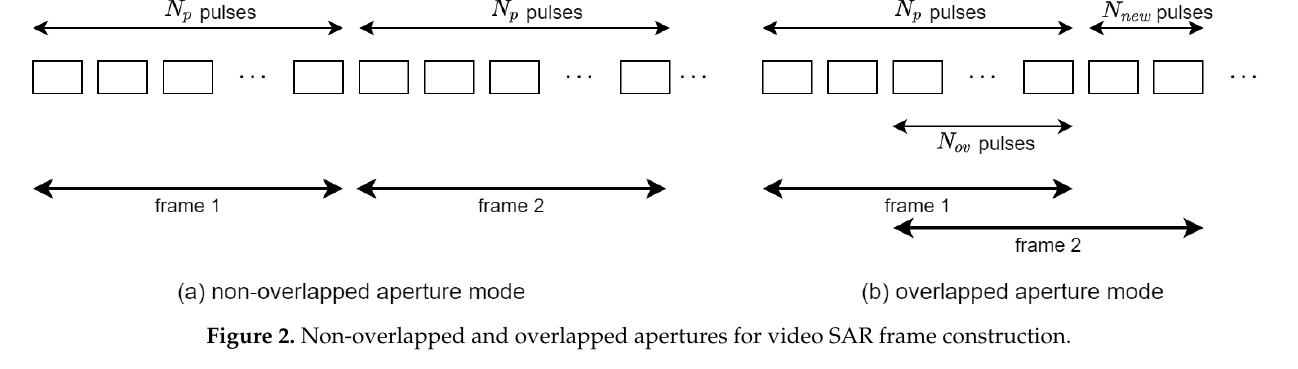
Figure 2. Non-overlapped and overlapped apertures for video SAR frame